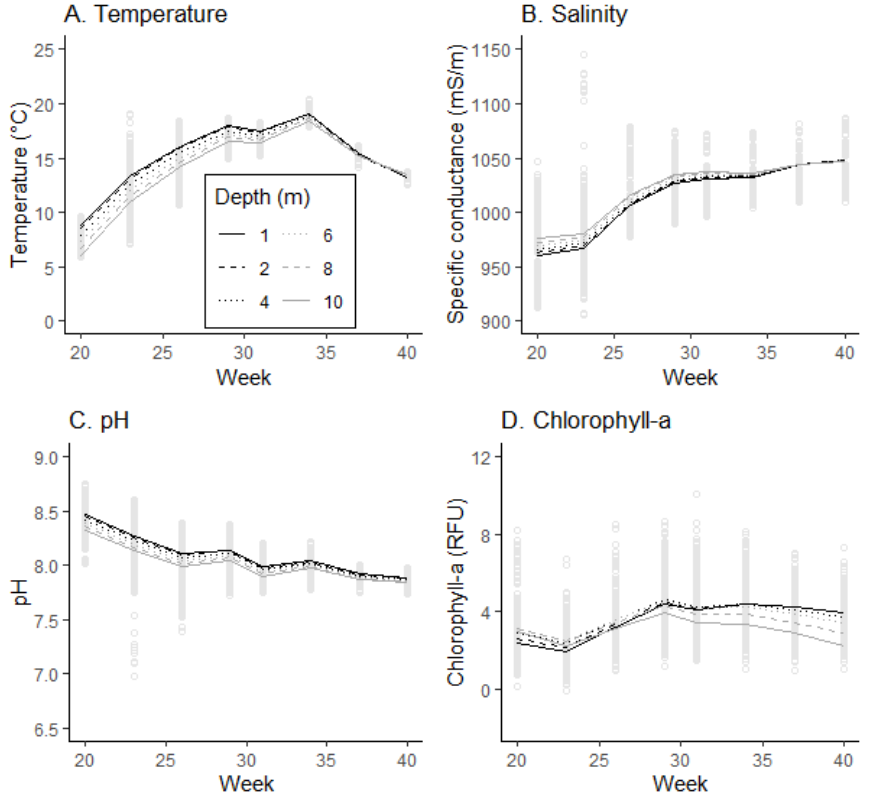
Figure 3. Interactive effects of “week” and “depth” on ( A ) temperature, ( B ) salinity (specific conductance), ( C ) pH and ( D ) chlorophyll-a concentration based on the observation-level model. See Table 3 for the corresponding model structures and coefficients. All variables are shown on back-transformed scales and observations as grey dots.